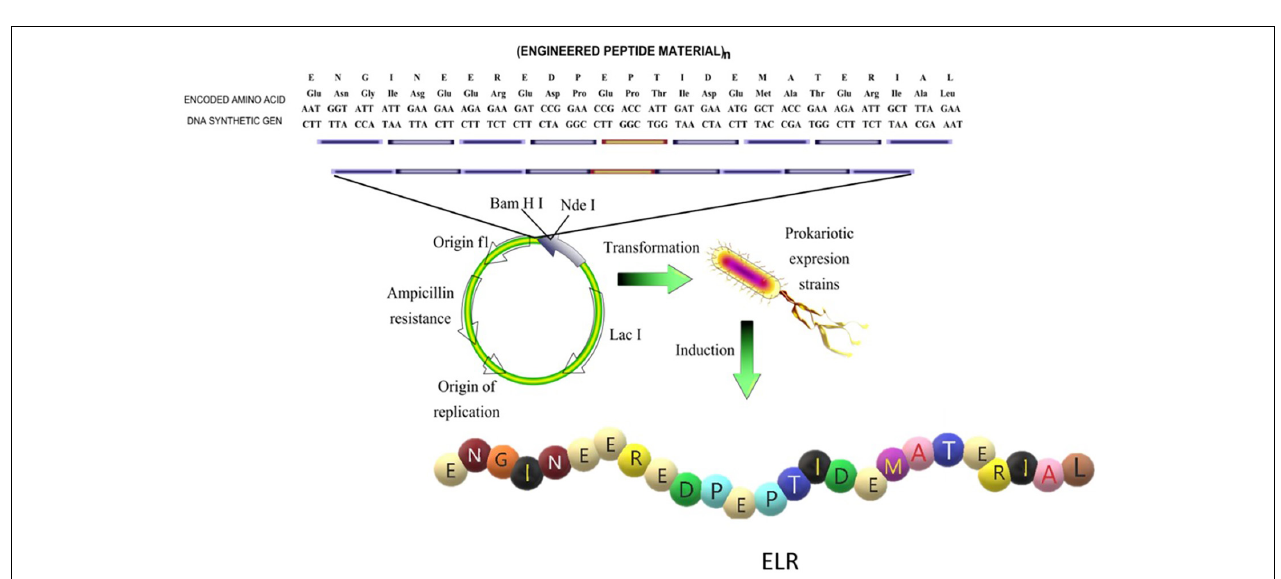
FIGURE 1 | Synopsis of the hierarchical structure of elastic fibers. The monomer of tropoelastin is composed of alternating GVP-rich hydrophobic domains and hydrophilic K-containing cross-linking domains. This monomer assembles into multimer that evolves into spherical aggregate structures. These spherules will form a microfibrillar scaffold to form an elastic fiber. Reproduced with permission from (doi.org/10.1002/mabi.201800250), copyright 2019.